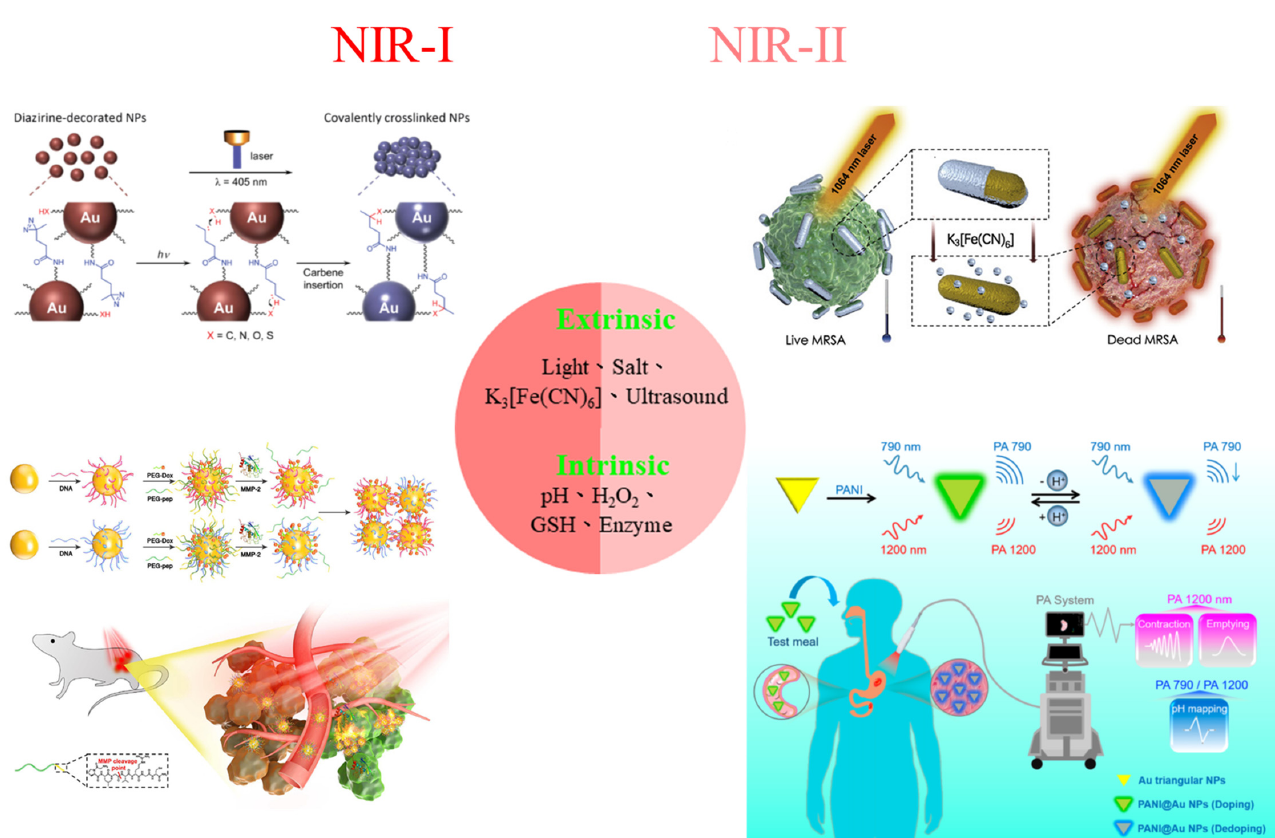
Figure 3. Activatable gold nanomaterials for PA imaging and PTT. Reprinted with permission from ref [88,90–92].